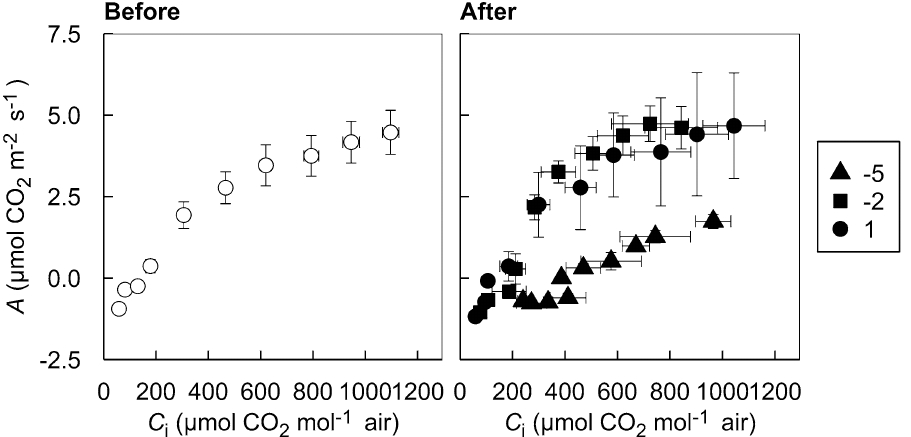
Figure 4. A – C i curves, light-saturated net photosynthetic CO 2 assimilation rate ( A ) as a function of intercellular CO 2 concentration ( C i ) of three-year-old ‘Hass’ avocado seedling leaves before (left) and after (right) short-term low temperature treatments. All symbols present the mean responses of biological replications ( n = 6 and 3 for before and after treatments, respectively). Error bars show the standard errors of the means for A (vertical) and C i (horizontal). Closed triangles, squares, and circles indicate the responses of the samples after treated with 1 h 1, − 2, and − 5 °C, respectively.